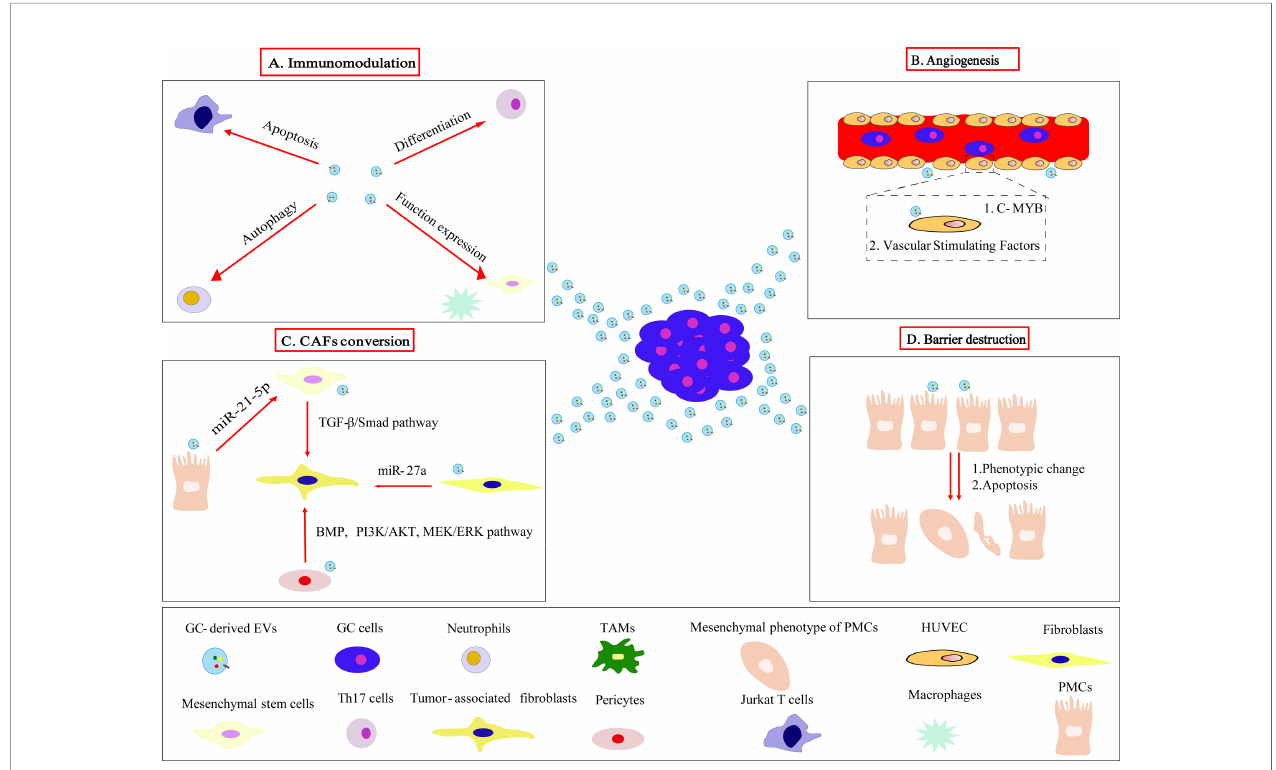
FIGURE 2 | GC-derived EVs acts on target cells to mediate the formation of pre-metastasis niche. (A) GC-derived EVs modulate the immune microenvironment by inducing Jurkat T cells apoptosis, neutrophils autophagy, Th17 cells differentiation, functional expression of macrophages and mesenchymal stem cells, eventually promoting tumor progression and metastasis. (B) GC-derived EVs target c-MYB on vascular endothelial cells and regulate vascular stimulating factors to promote angiogenesis. (C) GC-derived EVs convert fi broblasts, pericytes, mesenchymal stem cells, PMCs to CAFs through different mechanisms. (D) Phenotypic changes and apoptosis of PMCs induced by GC-derived EVs clear the peritoneal mesothelial cell barrier